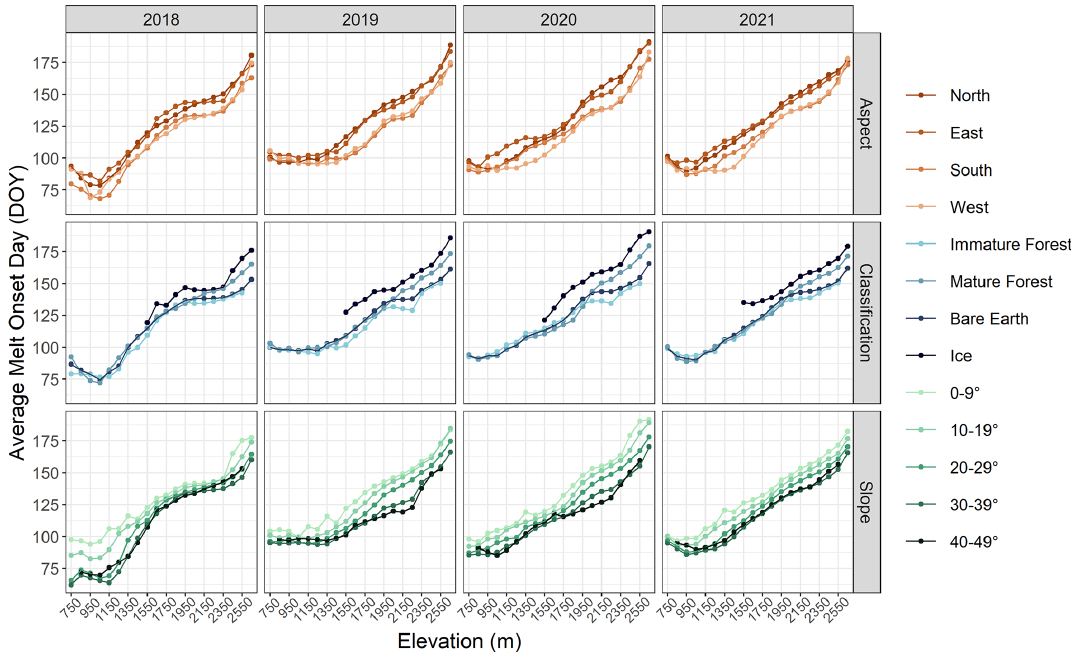
Figure 7. Average estimates of snowmelt onset by elevation, aspect, classification, and slope. Estimates of melt onset are inferred from minima in Sentinel-1 SAR time